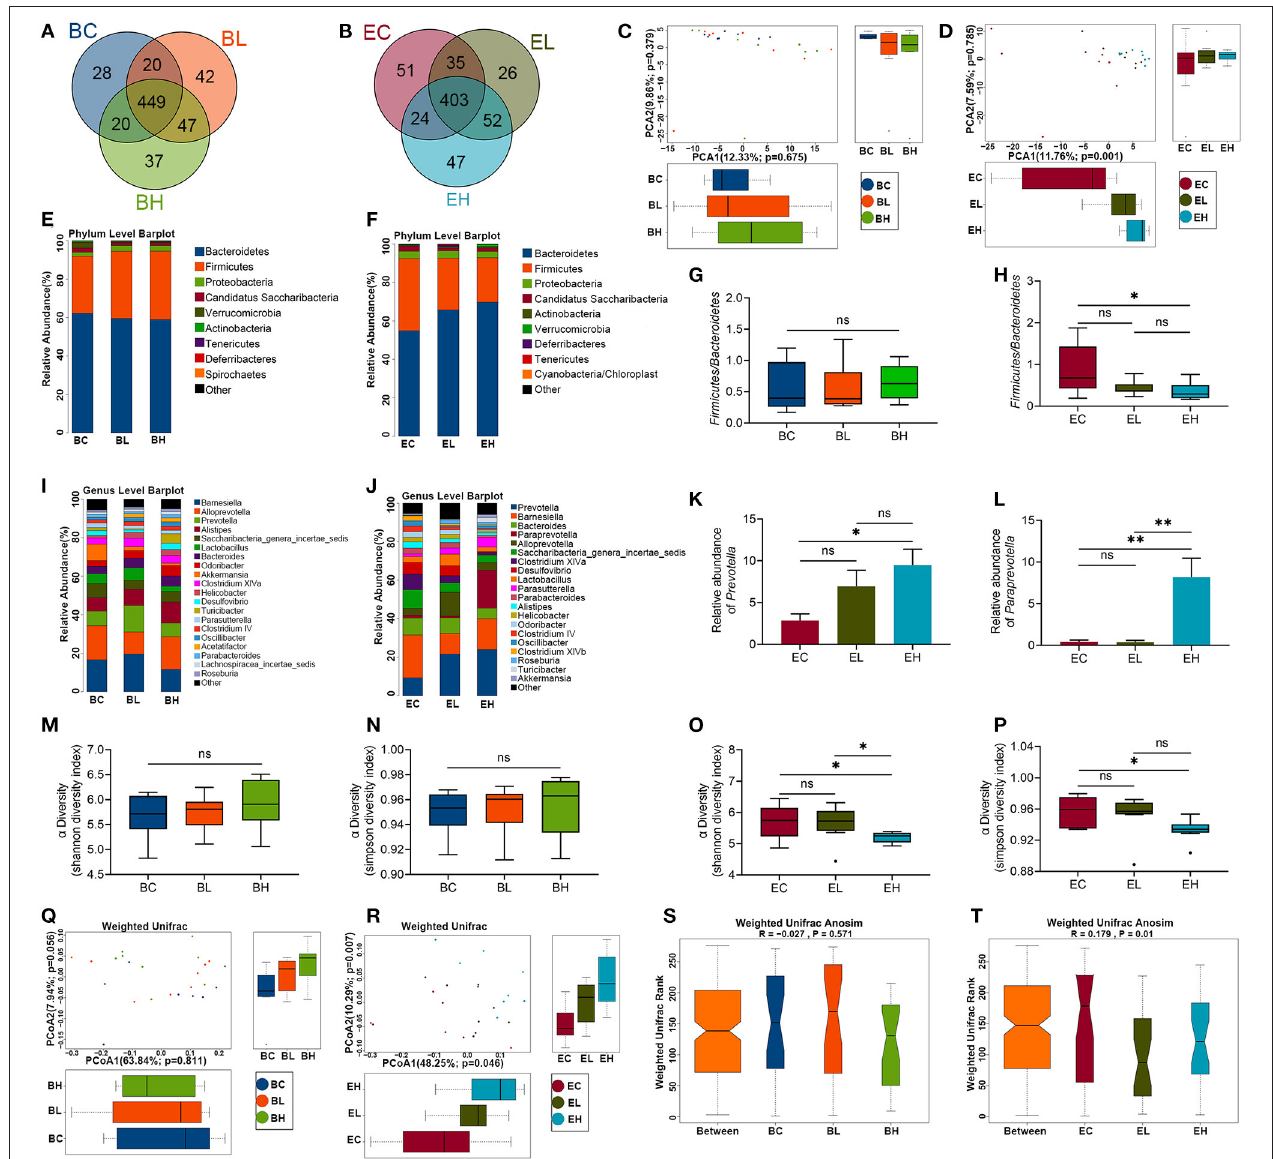
FIGURE 4 | Microbiota richness and diversity before and after leucine supplementation. (A,B) OTU Venn diagrams in gut microbiota in the baseline and endpoint groups; (C,D) OTU principal component analysis (PCA) plots in the baseline and endpoint groups; (E,F) relative abundance of microbiota at phylum level in the baseline and endpoint groups; (G,H) the ratios of Bacteroidetes and Firmicutes in the baseline and endpoint groups; (I,J) relative abundance of top 20 genera in the baseline and endpoint groups; (K,L) relative abundance of Prevotella and Paraprevotella in endpoint groups; (M,N) Shannon and Simpson diversity index in the baseline groups; (O,P) Shannon and Simpson diversity index in the endpoint groups; (Q,R) principal coordinates analysis (PCoA) plots in the baseline and endpoint groups; (S,T) analysis of similarity (ANOSIM) analysis in the baseline and endpoint groups; ns, no significance; * P < 0.05; and ** P <